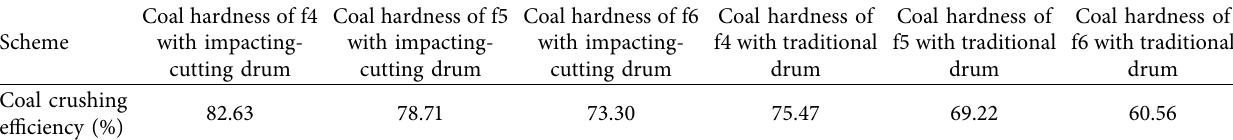
Table 3: Coal crushing efficiency of each